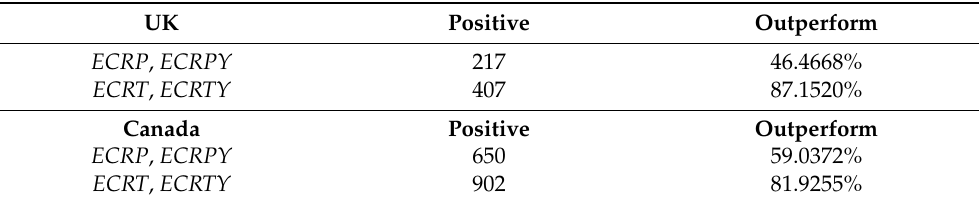
Table 4. The percentage of the underlying portfolios that outperform the structured products.